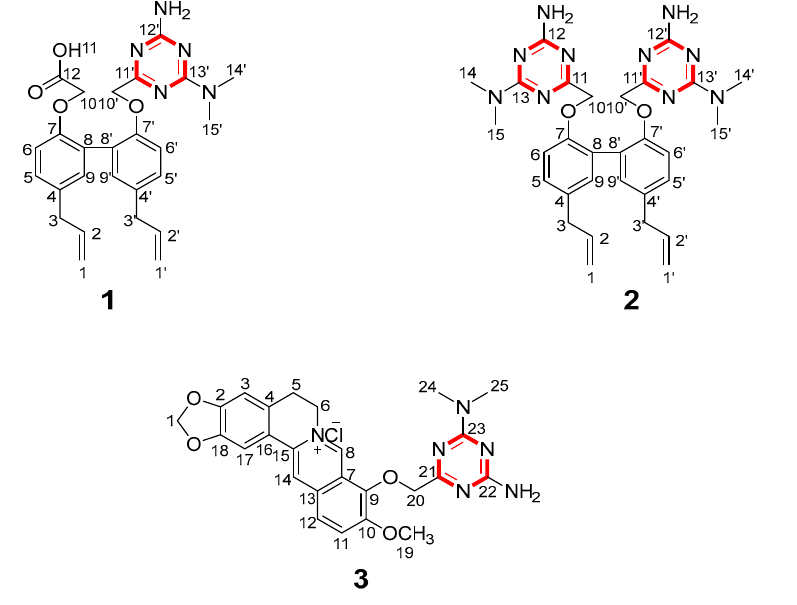
Figure 1. The structures of compounds 1 – 3 .